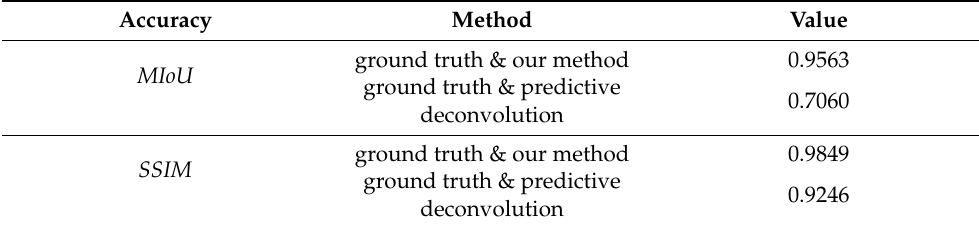
Table 3. The accuracy comparison.